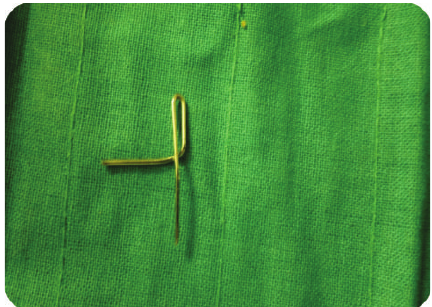
Figure 5: Fabrication of post and core: one of the arms’ is bent downwards and turned to the opposite side.